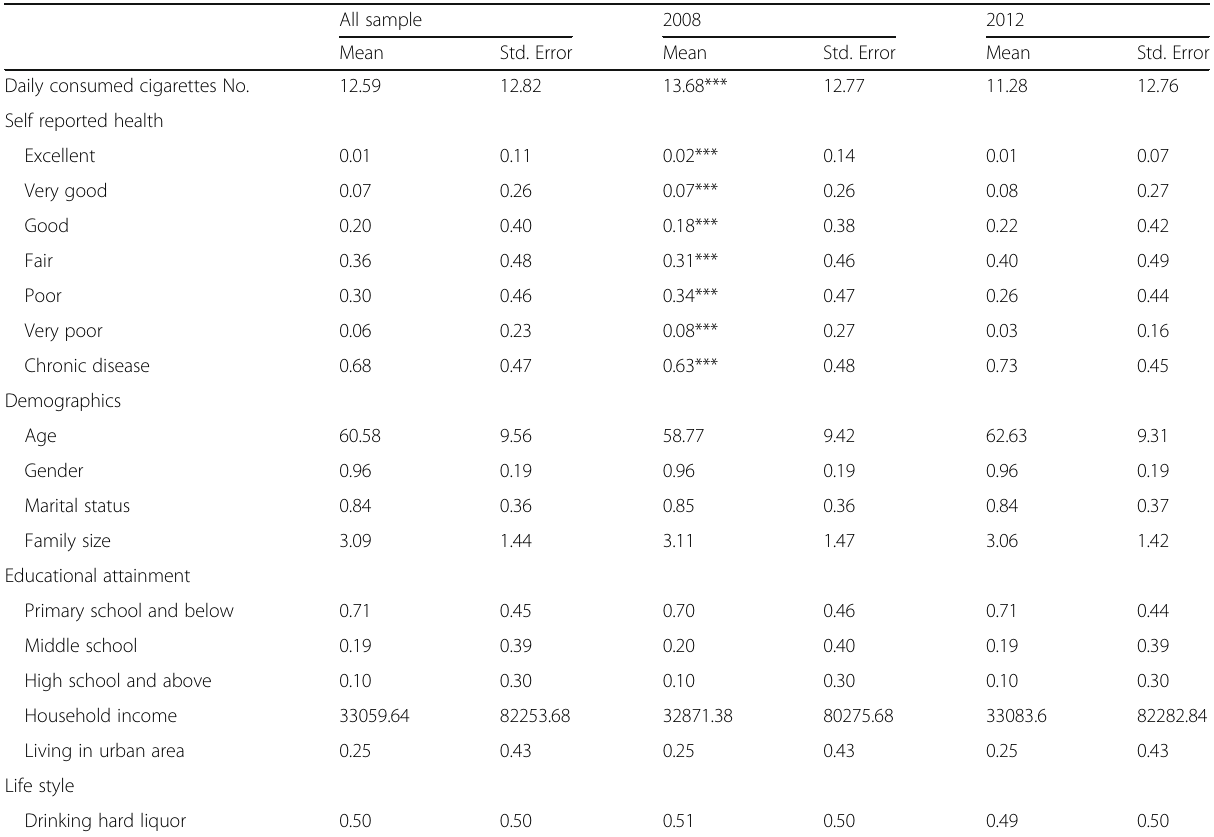
Table 2 Individual socioeconomic and life style characteristics All sample 2008